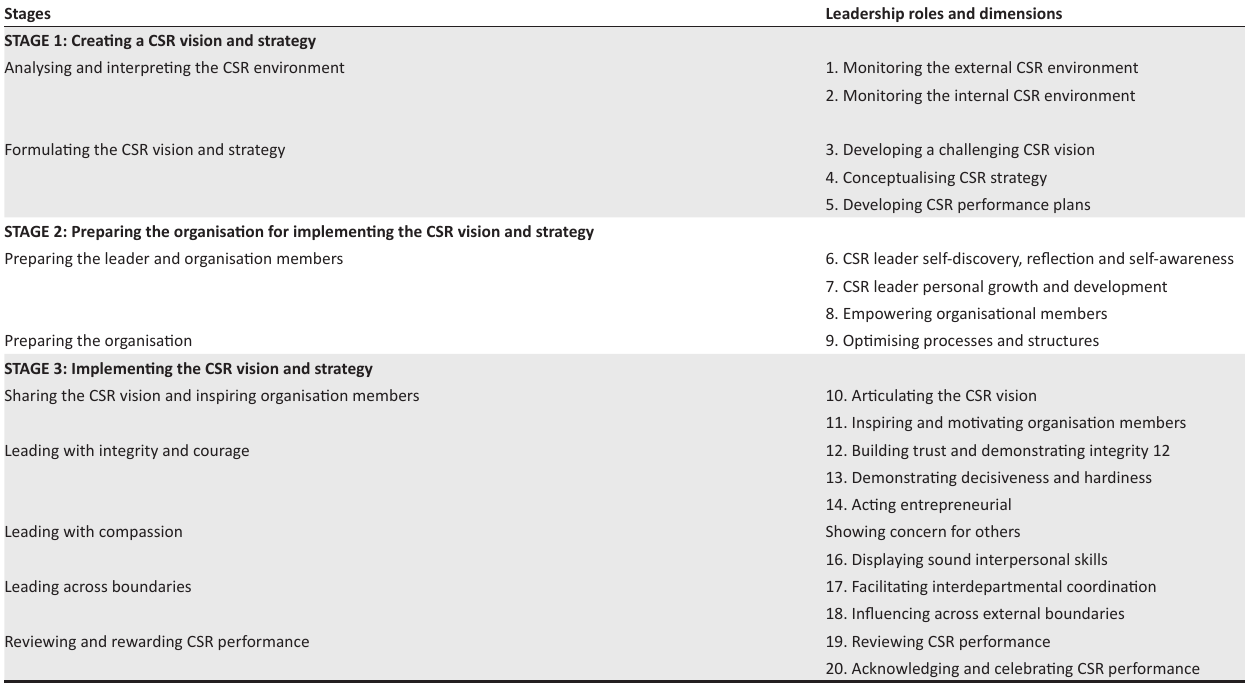
TABLE 1: Adapted LBI-2 stages, leadership roles and dimensions for